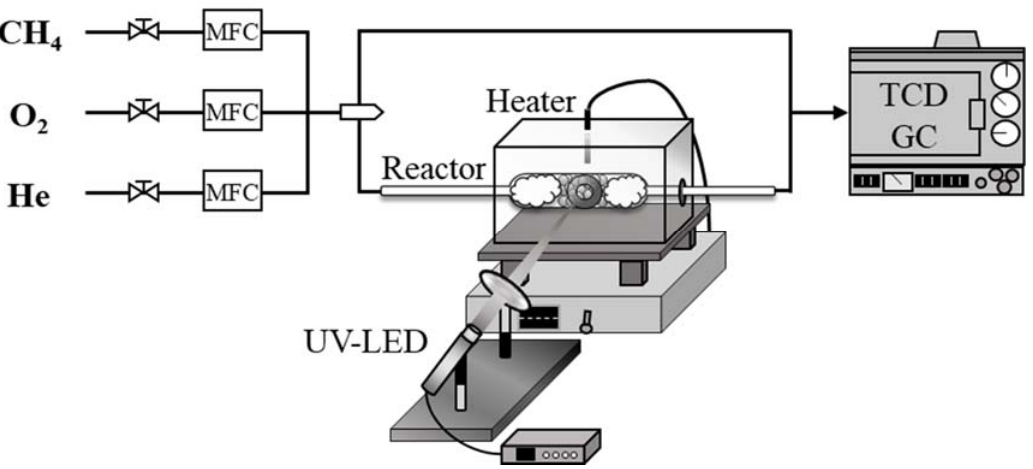
Scheme 4. Fixed ‐ bed continuous ‐ flow quartz reactor with UV ‐